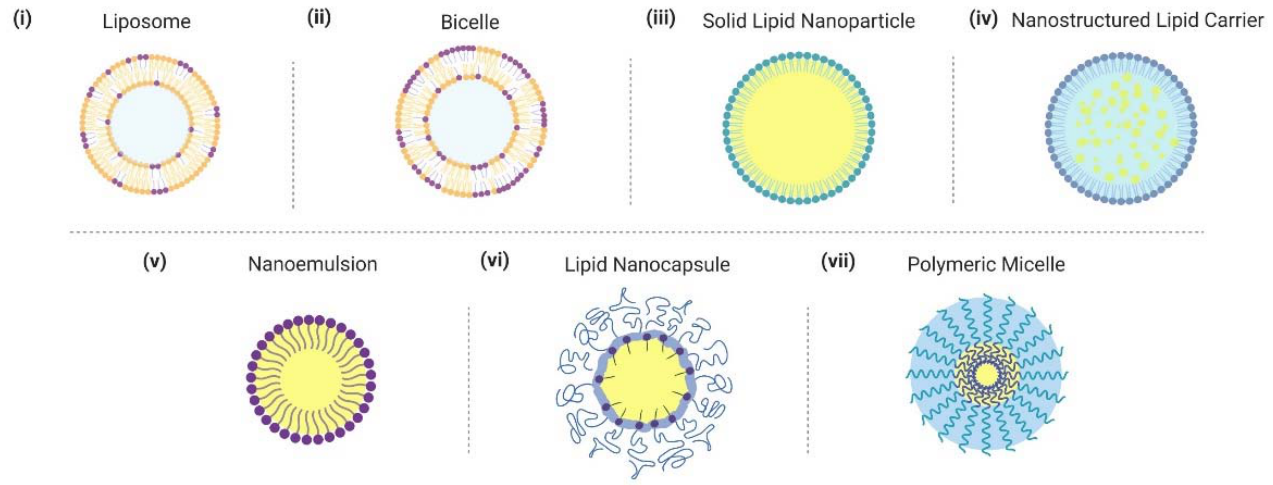
Figure 2. Overview of lipid nanoparticle strategies and related nano-carrier formulations for delivering fatty acids and monoglycerides. Graphical illustrations of different nanoparticles are presented. Nanoparticles are not drawn to scale.